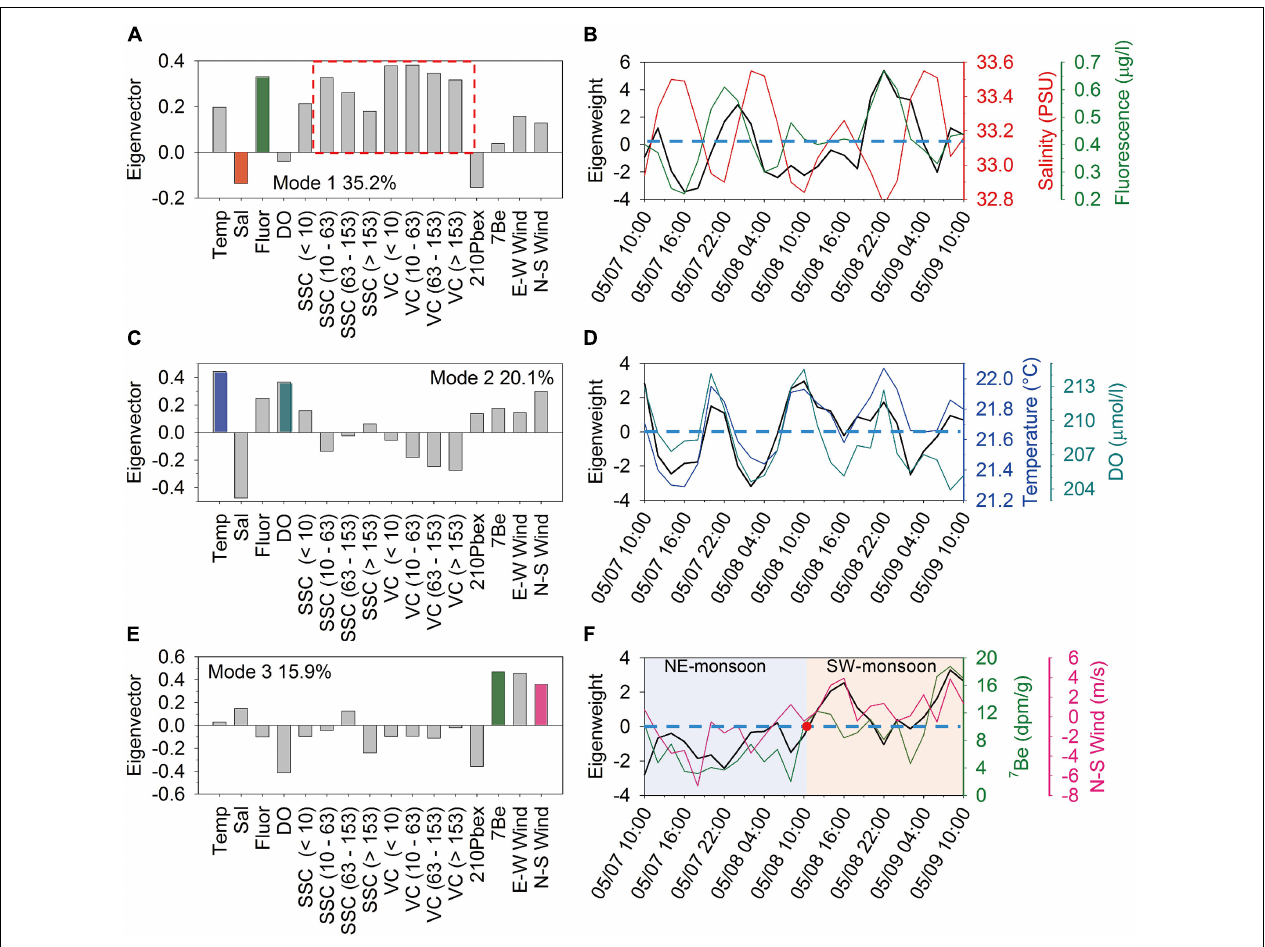
FIGURE 8 | Plots of EOF analysis result on the 16 variables in the lower water column and in the surface sediment showing (A) Mode 1 eigenvectors (the red dashed box show the suspended sediment attributes); (B) Mode 1 eigenweighting curve with salinity and fluorescence as comparison; (C) Mode 2 eigenvectors; (D) Mode 2 eigenweighting curve with temperature and DO as comparison; (E) Mode 3 eigenvectors; (F) Mode 3 eigenweighting curve with 7 Be and N-S wind as comparison (the dotted blue line shows the zero value of the eigenweightings). The red dot shows the position of zero-crossing on Mode 3 eigenweighting